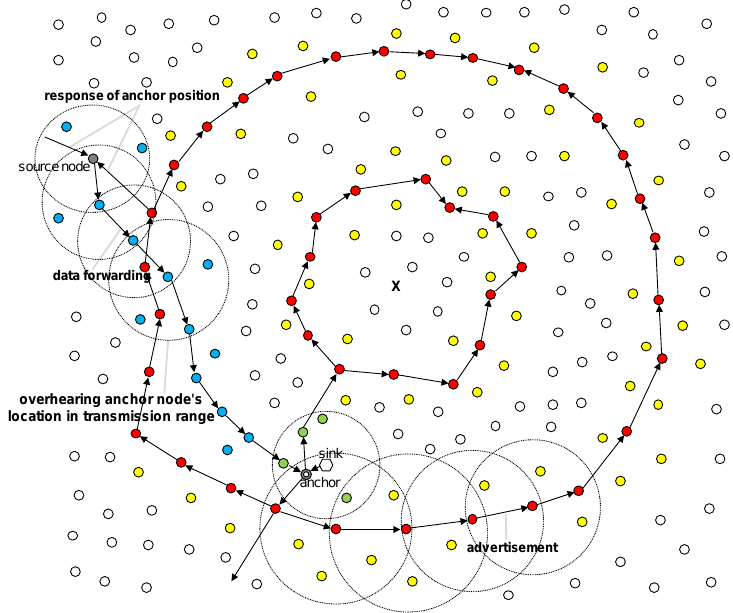
Figure 12. Overhearing anchor’s